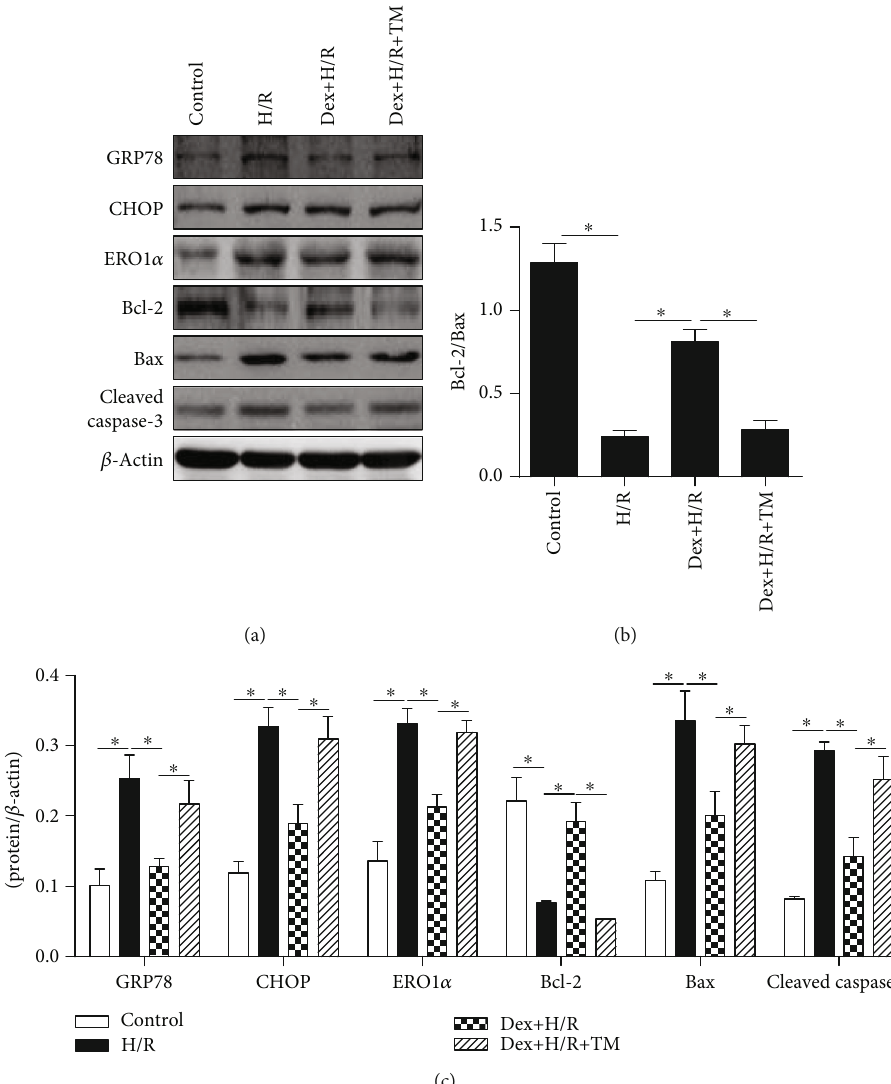
Figure 7: Dex reduces apoptosis of H9C2 cells after H/R injury, which was blocked by ERS agonist tunicamycin. (a) Western blot. (b) The bar graph of Bcl-2/Bax. (c) The bar graph of protein expression. All results are expressed as the mean ± SD . ∗ P < 0 : 05 between each